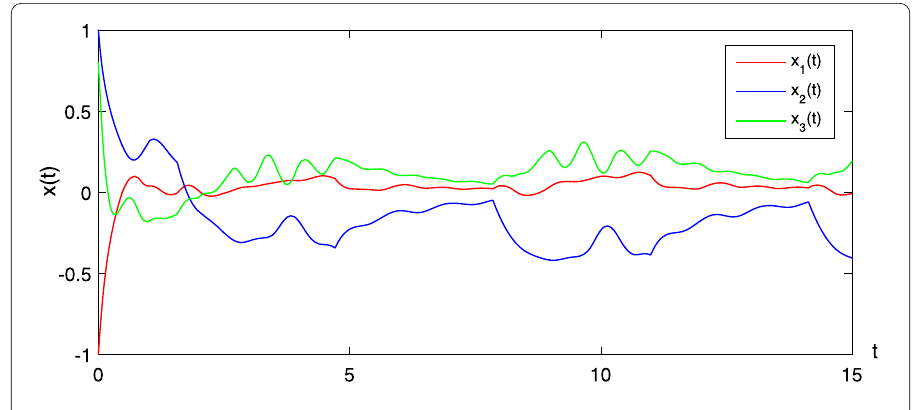
Figure 2 Simulation for Example 2 when ( T , r 1 , r 2 ) =